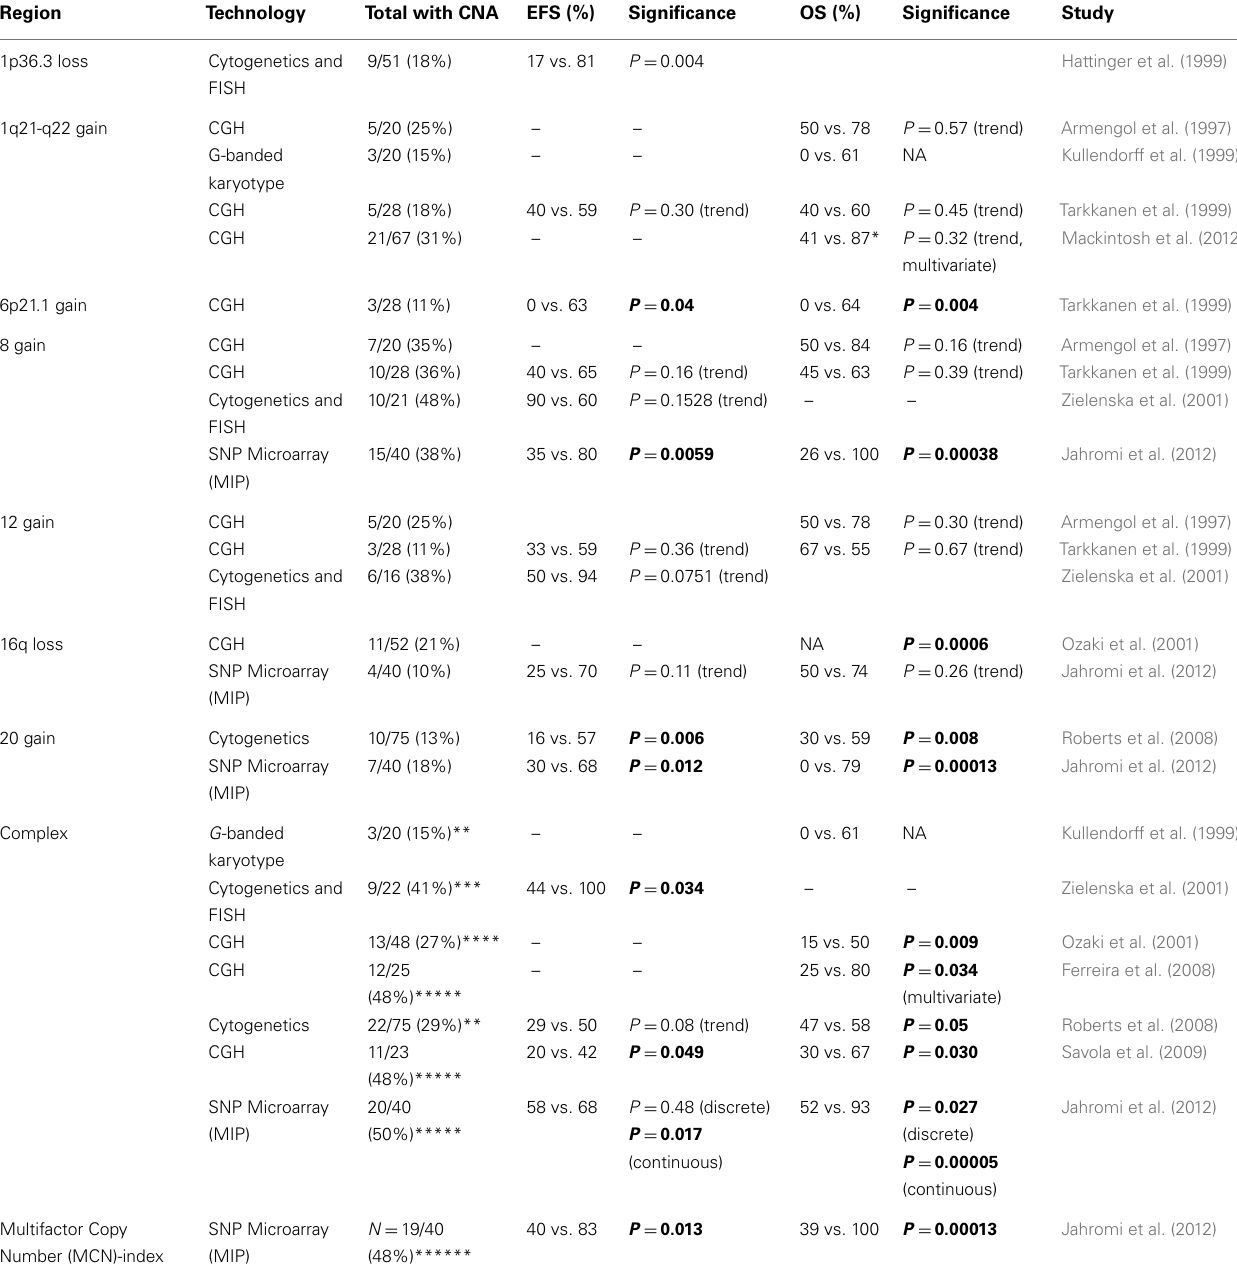
Table 3 | Recurrent CNAs and outcome correlations in Ewing sarcoma